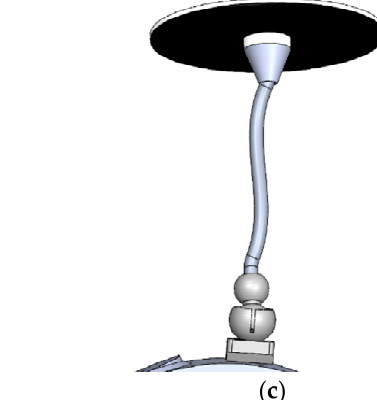
Figure 5. Add-ons: ( a ) Control unit; ( b ) Anchoring the camera; ( c ) Mirror anchor.